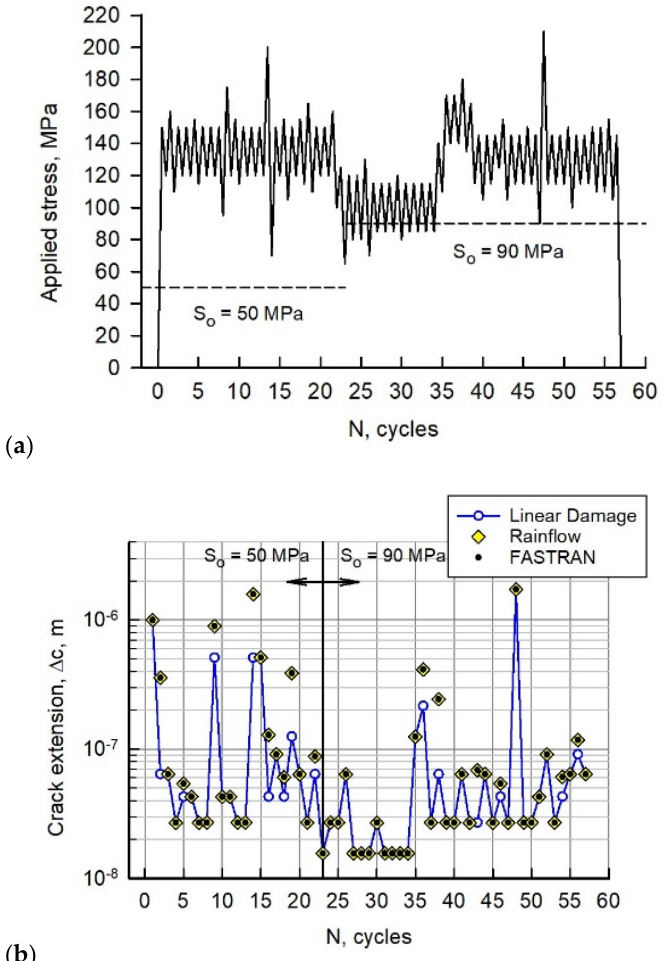
Figure 5. ( a ) Loading sequence B. ( b ) Calculated crack extension per applied cycle for load sequence B2.